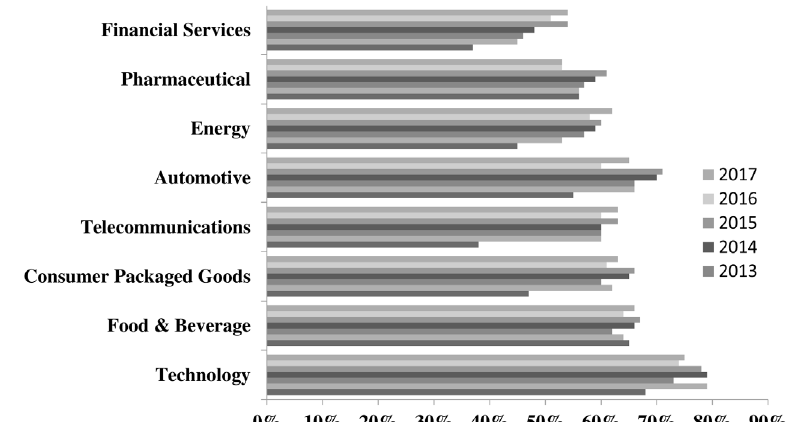
Figure 1. Edelman and Trust Report on Trusted Industries (2011 to